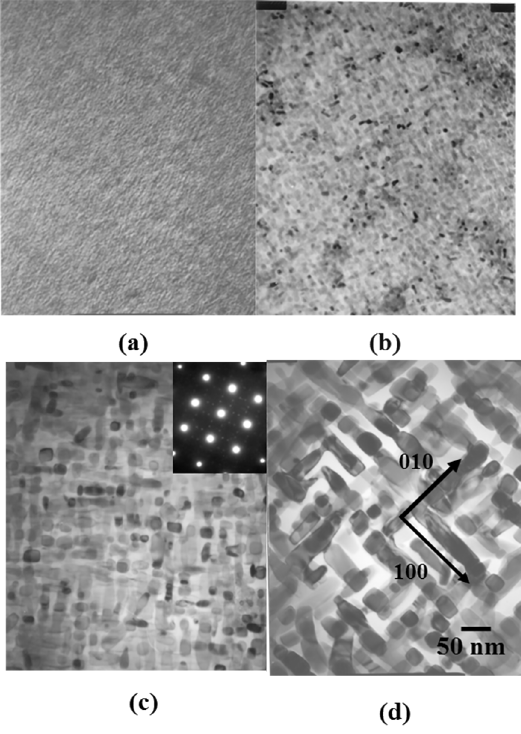
Figure 1. BF-TEM micrographs of Cu-4wt. % Ti alloy aged at 400 °C for (a) 5 h, (b) 25 h, includes its corresponding electron diffraction pattern, (c) 100 h and (d) 200 h.